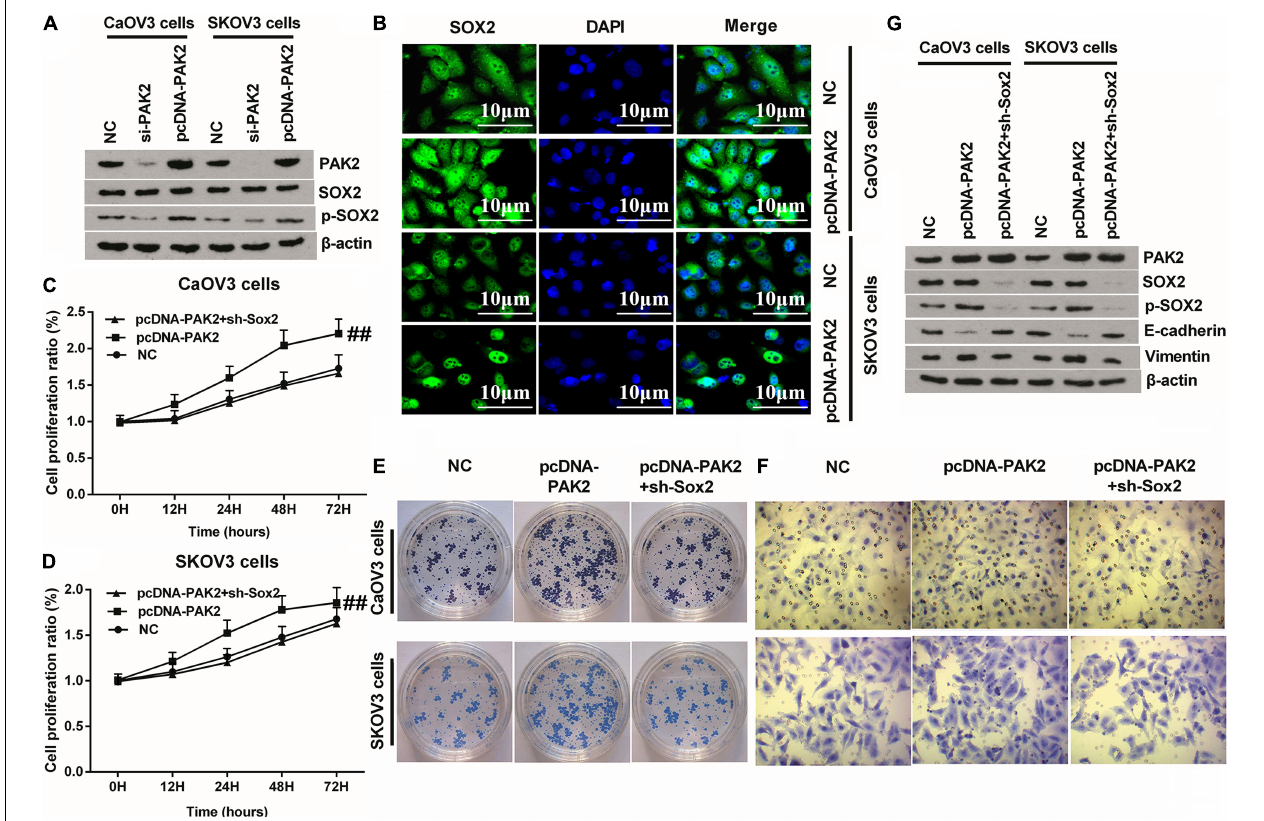
FIGURE 6 | Knockdown of SOX2 notably reversed PAK2 overexpression-triggered tumor-promoting effects. (A) PAK2 overexpression notably have no notable influence on the expression of SOX2, but obviously increased the expression of p-SOX2. (B) PAK2 overexpression promoted the nuclear translocation of SOX2. (C–F) Knockdown of SOX2 obviously reversed PAK2 overexpression-induced augmenting effects on the proliferation, colony formation, and migration of CaOV3 and SKOV3 cells. (G) PAK2 overexpression obviously decreased the expression of EMT-associated E-cadherin, and increased the expression of Vimentin. Knockdown of SOX2 notably counteracted PAK2 overexpression-induced effects. PAK2, P21 (RAC1) activated kinase 2; SOX2, SRY-box transcription factor 2; EMT, epithelial–mesenchymal transition. ## p < 0.01.